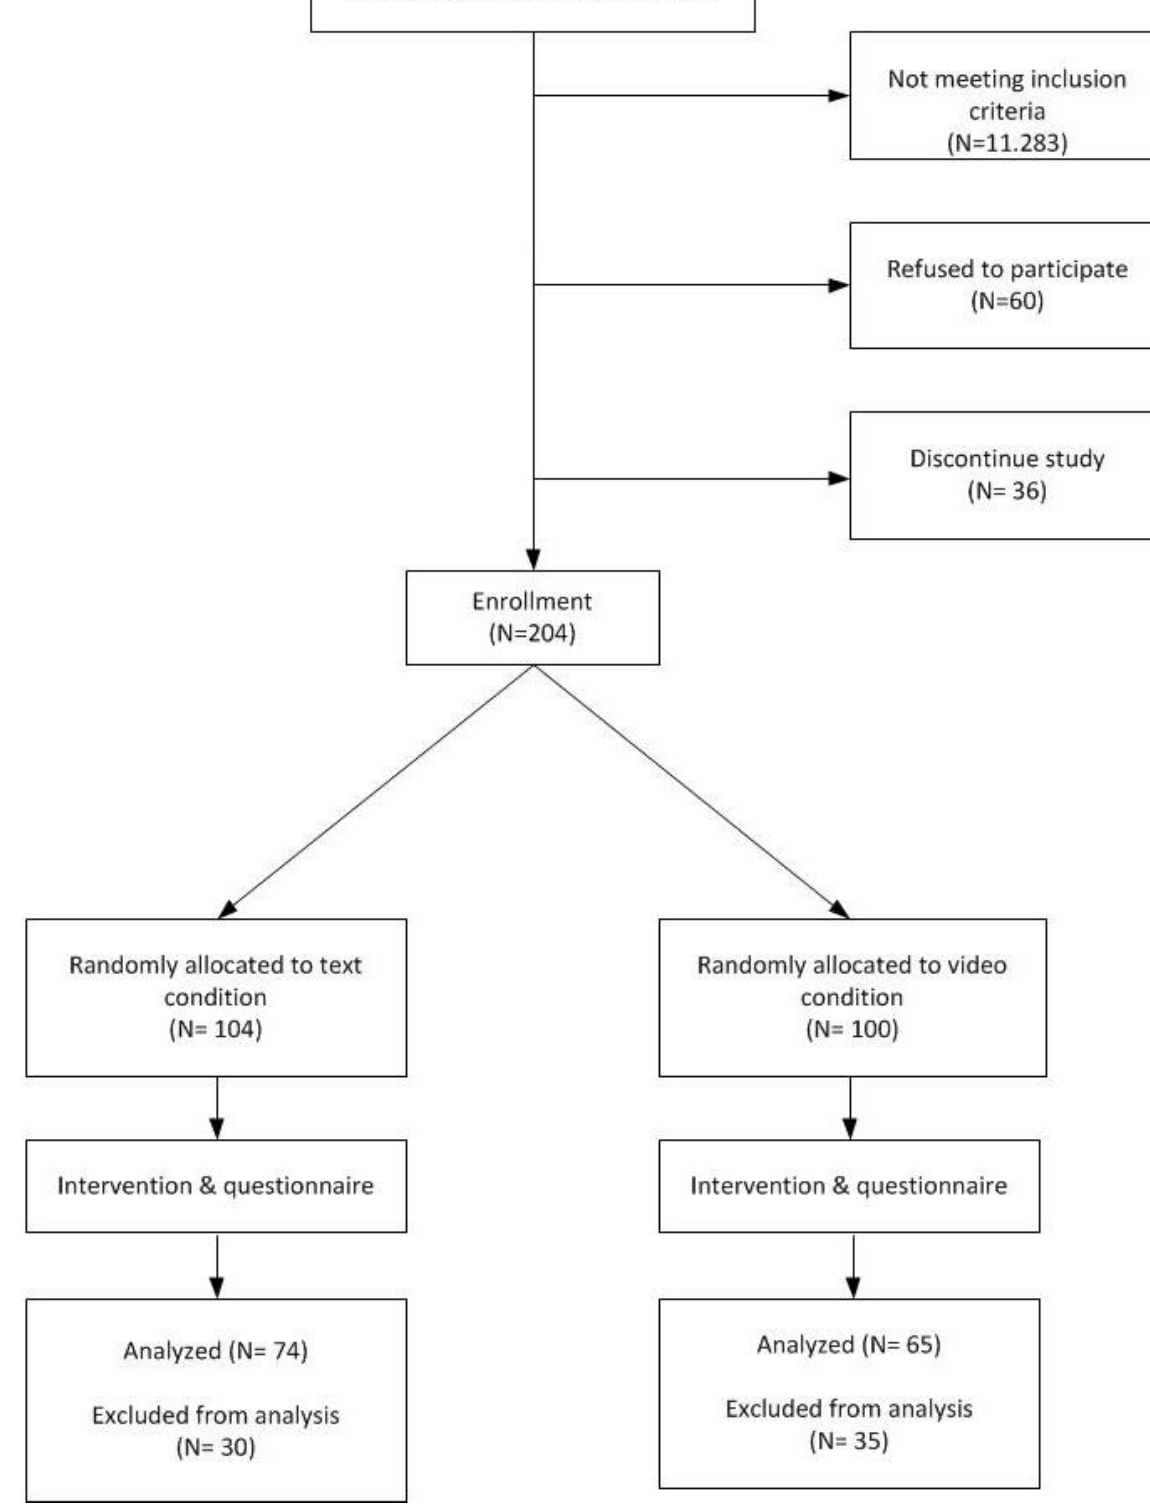
Figure 1. Flowchart of the